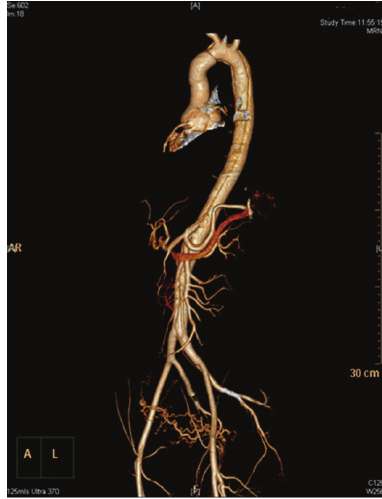
Figure 2: CT 3D reconstruction showing aortic dissection in the arch of the aorta extending along the descending thoracic aorta. Distally the dissection extends along the abdominal aorta up to the aortic bifurcations into the left common iliac